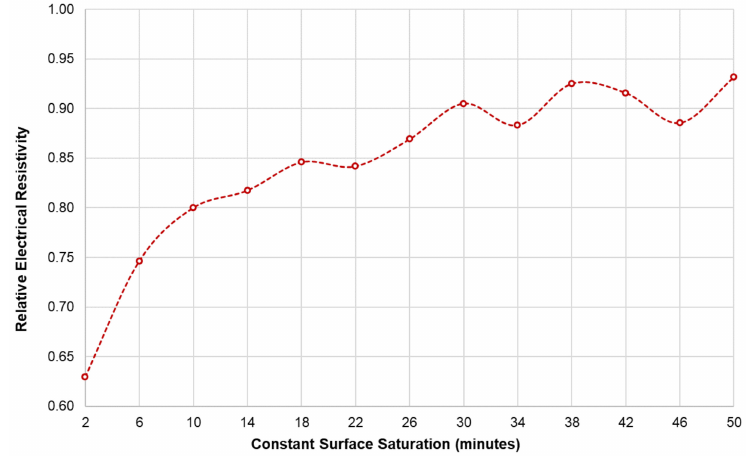
Figure 10. Variation of the relative ER values measured directly above a reinforcing bar in concrete specimens with respect to the surface saturation of concrete.